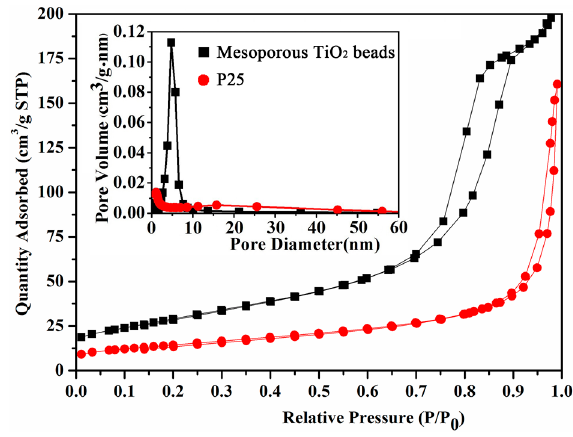
Figure 4. Nitrogen sorption isotherms of the mesoporous spherical TiO 2 and P25 TiO 2 .